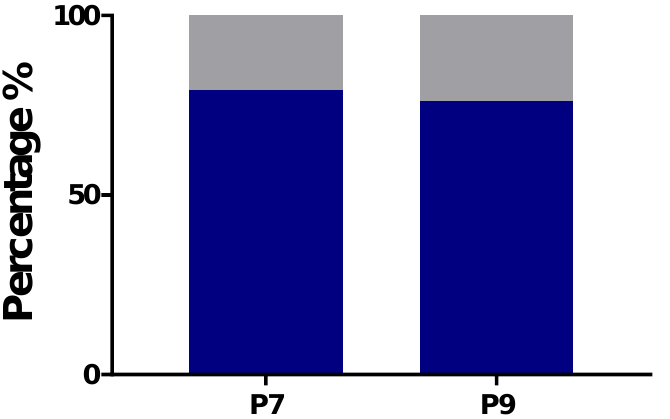
Figure 4. Percentage of CD4+ and CD8+ T cells in sequenced samples.